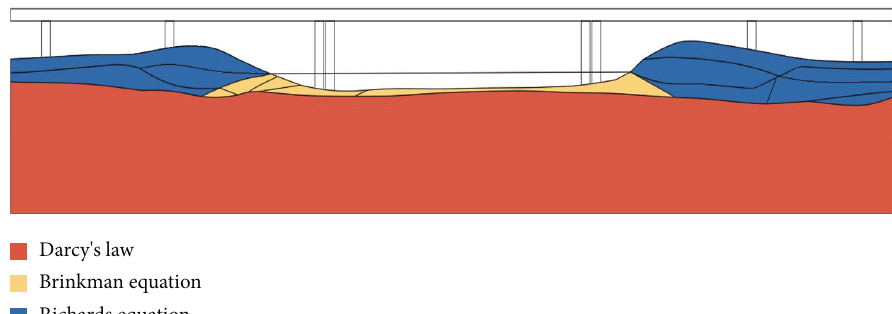
Figure 3: Seepage model used for each geotechnical